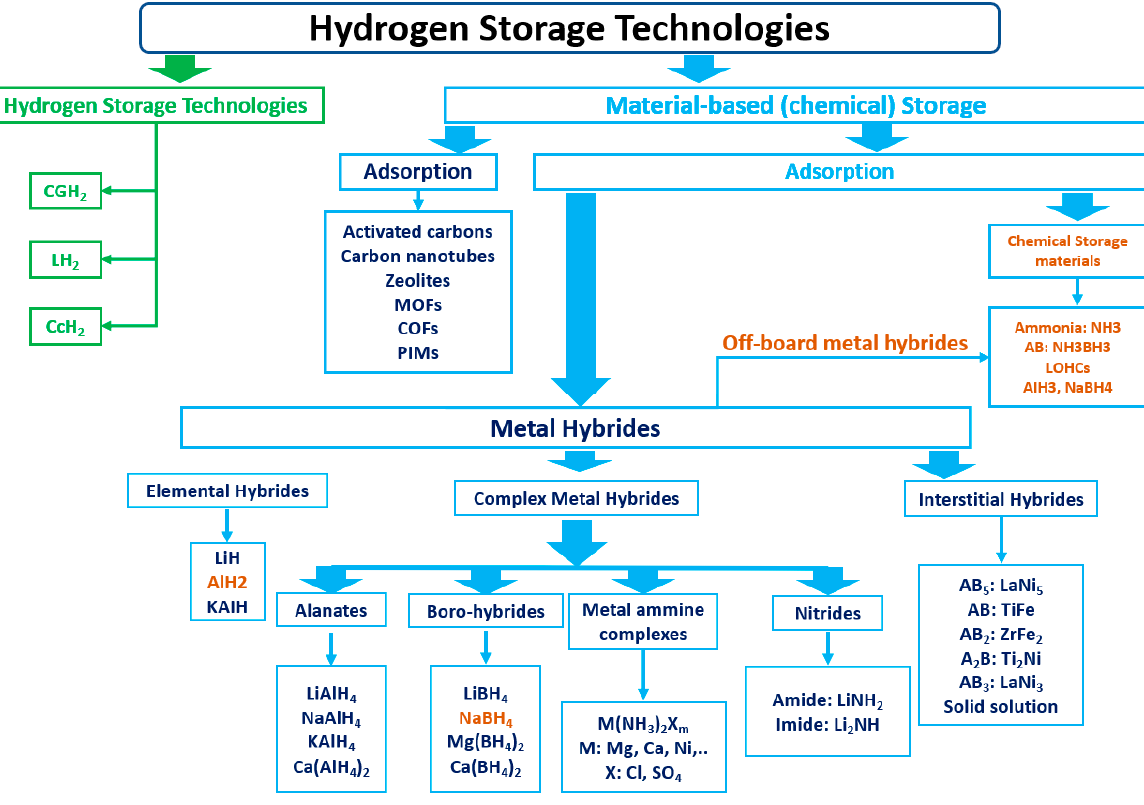
Figure 2. Different types of hydrogen storage [37].